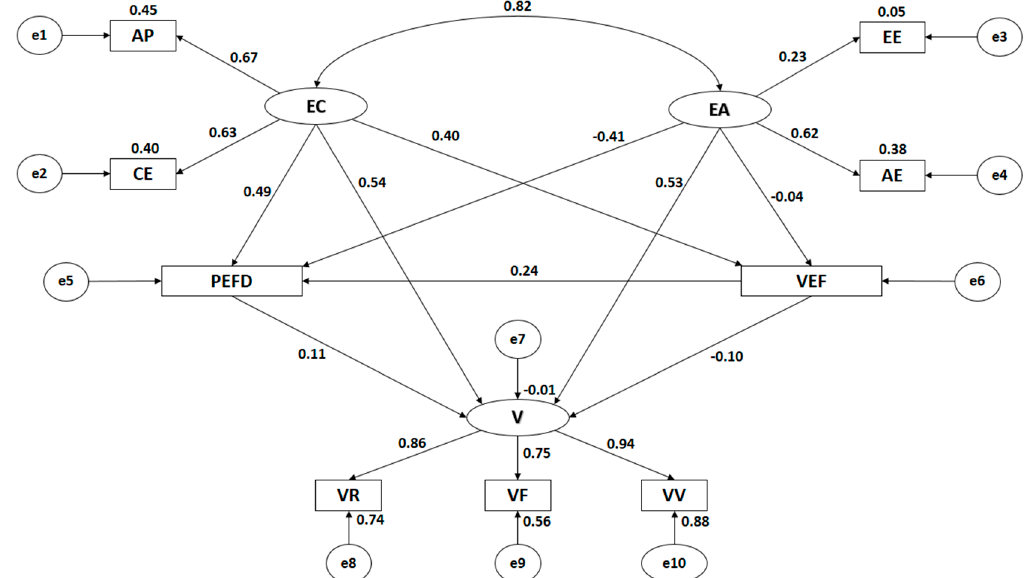
Figure 2. Structural equation model for individuals who regularly engaged in physical activity.